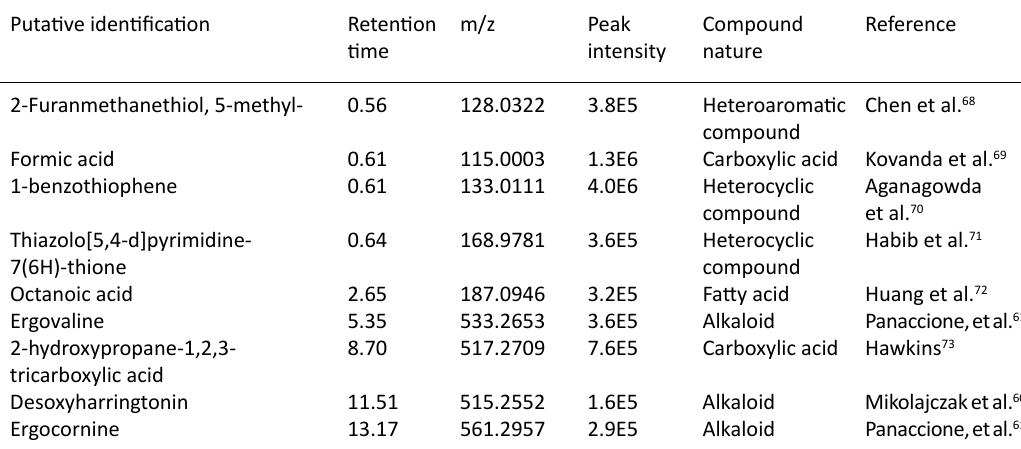
table 6. Putative compounds identification of hot water crude extract of G. boninense from PubChem by HPLC coupled with electrospray ionization mass spectrometry system